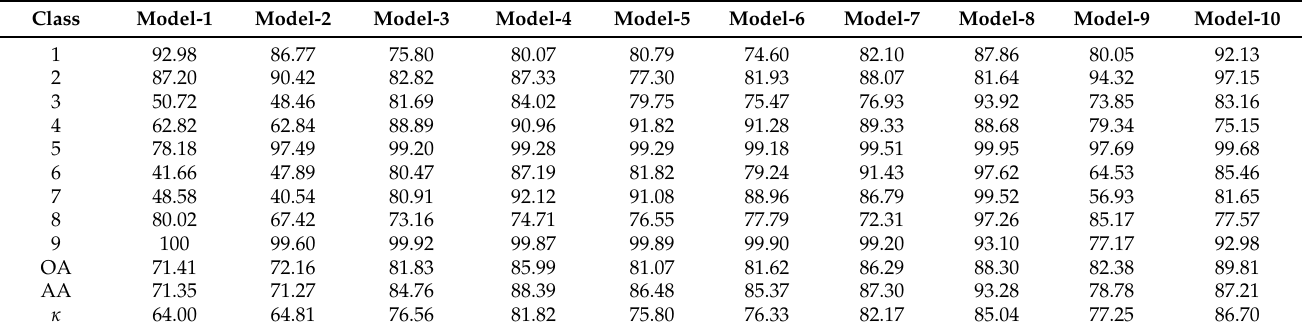
Table 7. Specific classification results of each model on the PaviaU